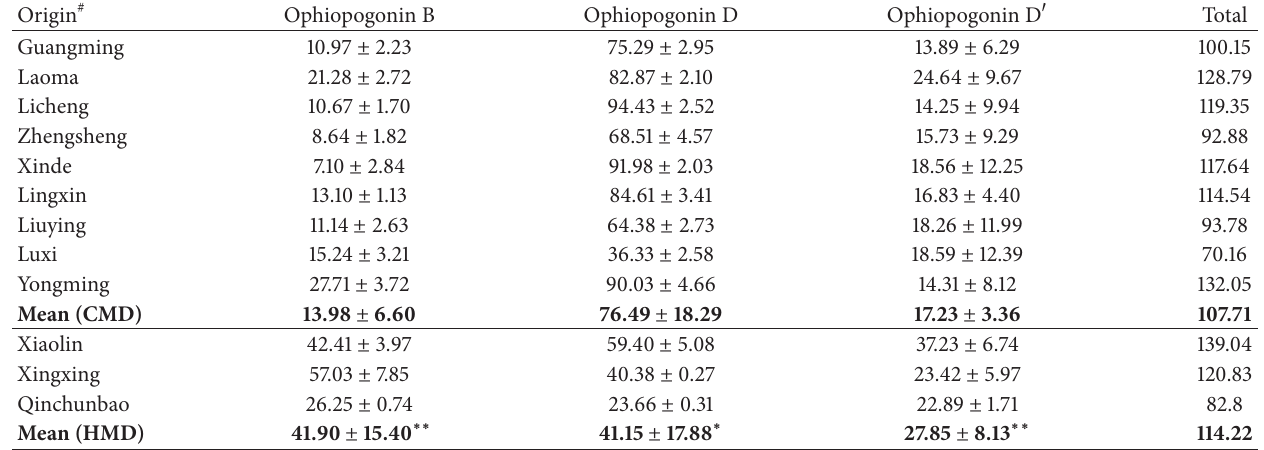
Table 1: The content of three saponins in tubers of HMD and CMD ( 𝜇